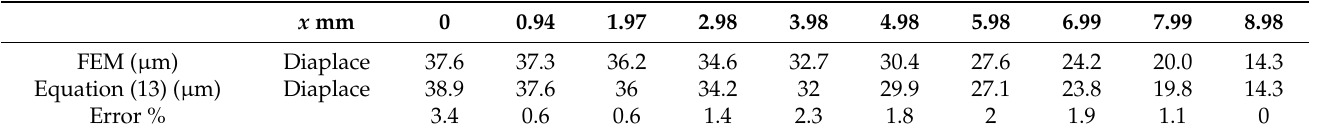
Figure 10. The stress nephogram of crack.